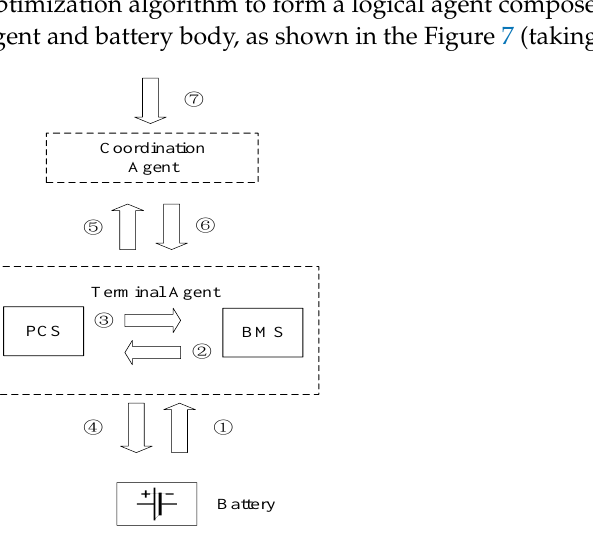
Figure 6. Voltage control block diagram.